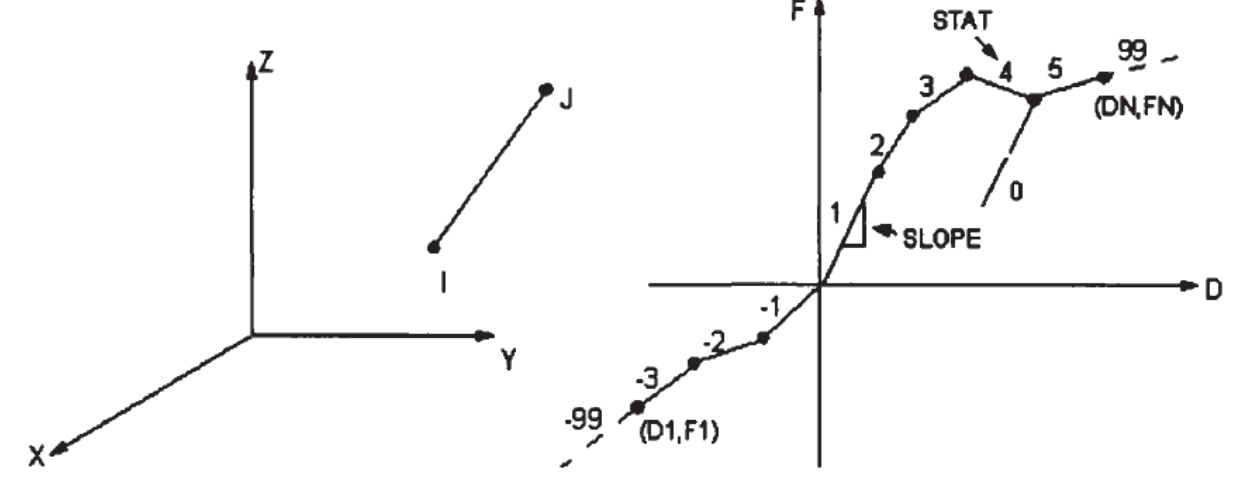
Figure 4: Nonlinear spring